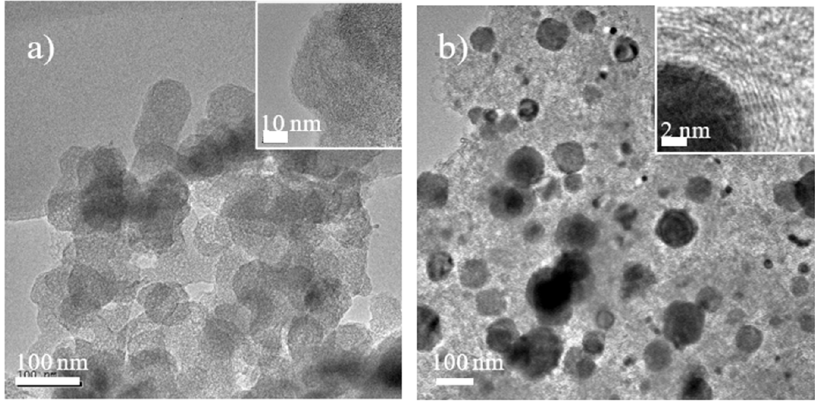
Figure 3. Transmission electron microscopy (TEM) image of porous carbon Zn/CN ( a ), and carbon layer in Zn/CN (inset in a), Co/CN ( b ) and carbon matrix layered coating on cobalt in Co/CN (inset in b).